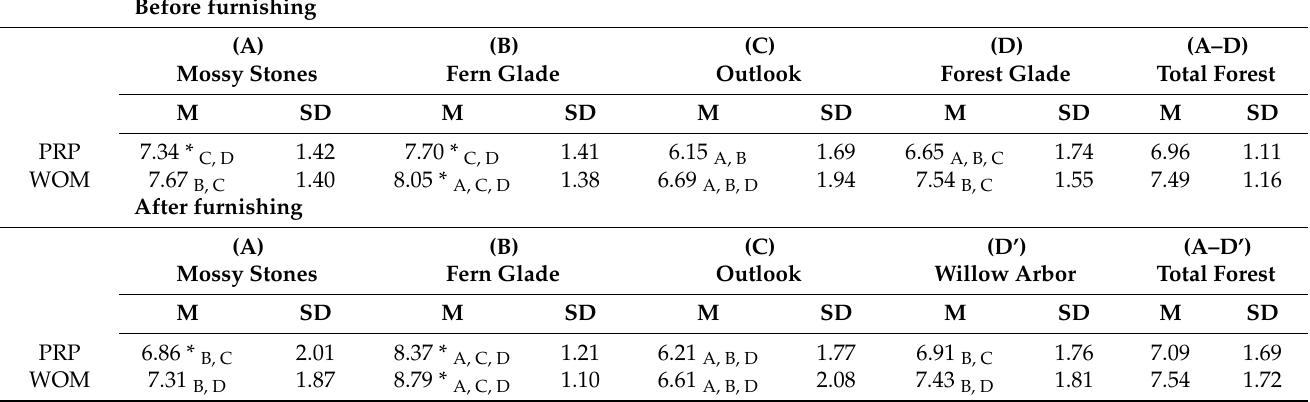
Table 2. Qualities of the places in the forest and the forest on